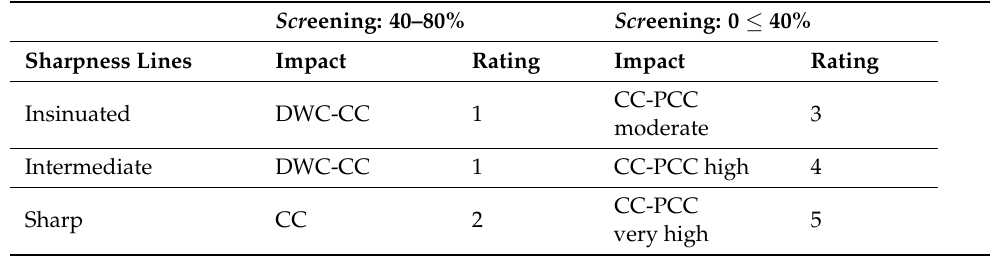
Table 1. Proposed assessment of screening impact ( Scr I). Qualitative classification of impact: DWC—diversity without contrast; CC—compatible contrast; PCC—poorly compatible contrast. Adapted from [11]. Scr eening: 40–80% Scr eening: 0 ≤